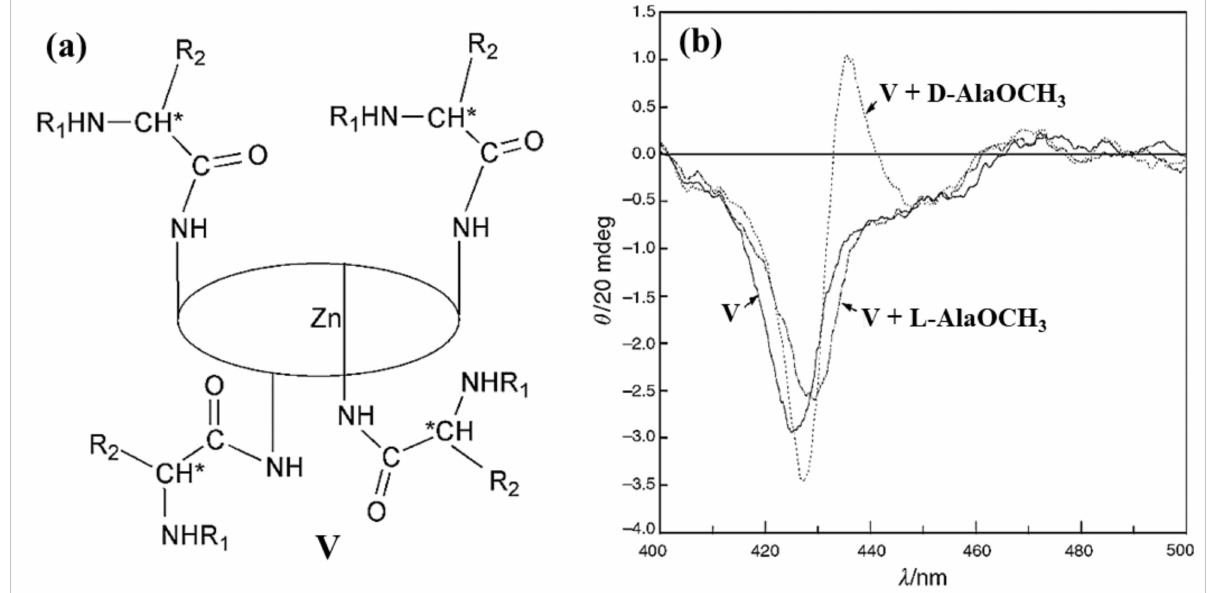
Figure 2. ( a ) Schematic of chiral porphyrin V synthesized by Zhu et al. The stereogenic centres are indicated by an asterisk (*); ( b ) CD spectra of chiral porphyrin V alone and in presence of L-AlaOCH 3 and D-AlaOCH 3 in dichloromethane at 298 K. Adapted with permission from reference [59]; published by Royal Society of Chemistry